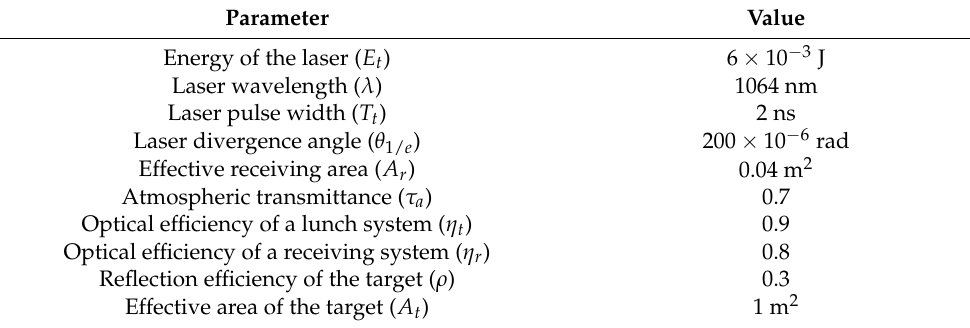
Table 4. The design parameters of the lidar system and the